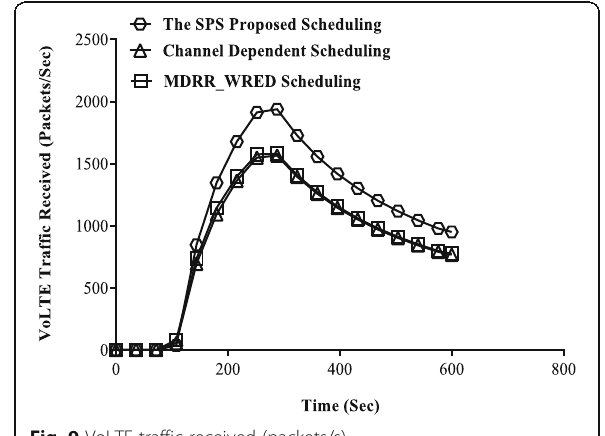
Fig. 9 VoLTE traffic received